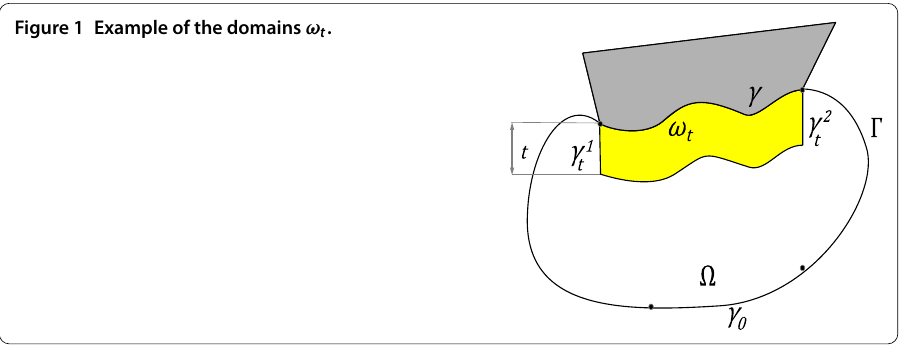
Figure 1 Example of the domains ω t